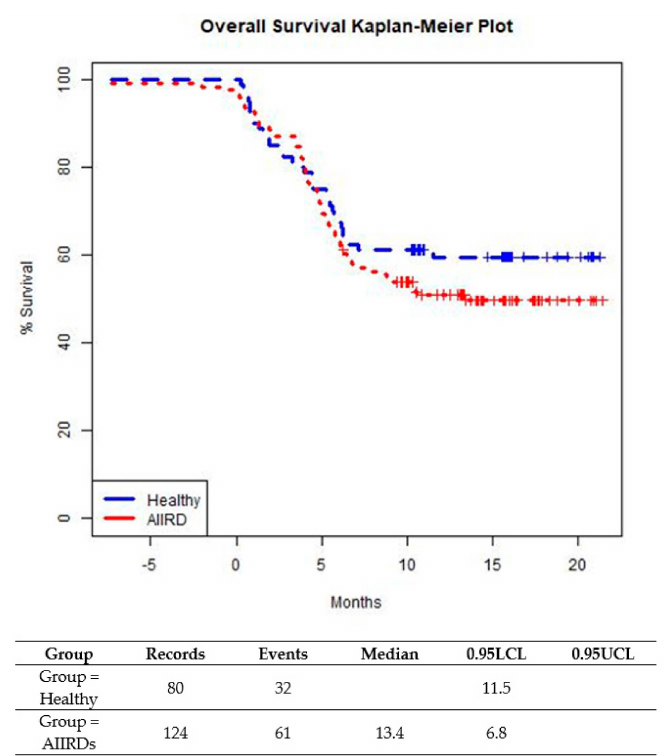
Figure 3. Time from last BNT162b2 vaccine dose to COVID-19 breakthrough infection in healthy adolescents and those with AIIRDs.Log-Rank p -value is